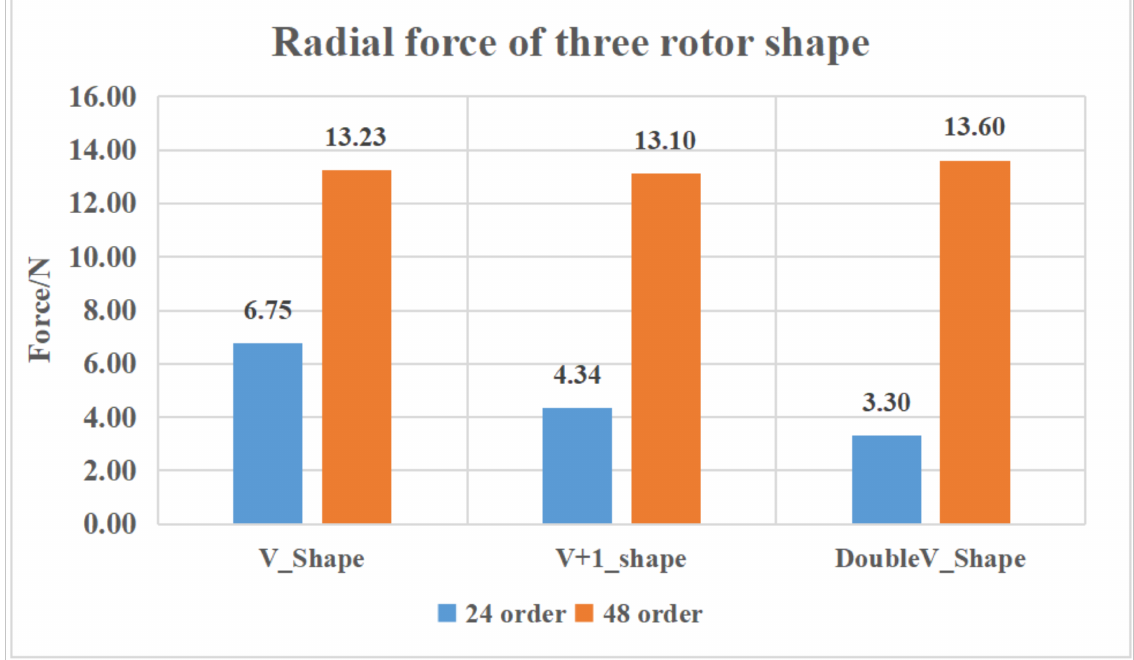
Figure 12. Order comparison of the three